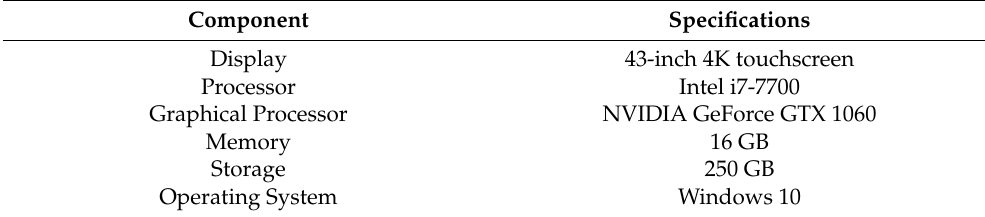
Table 1. Characteristics of Sensytouch ST43